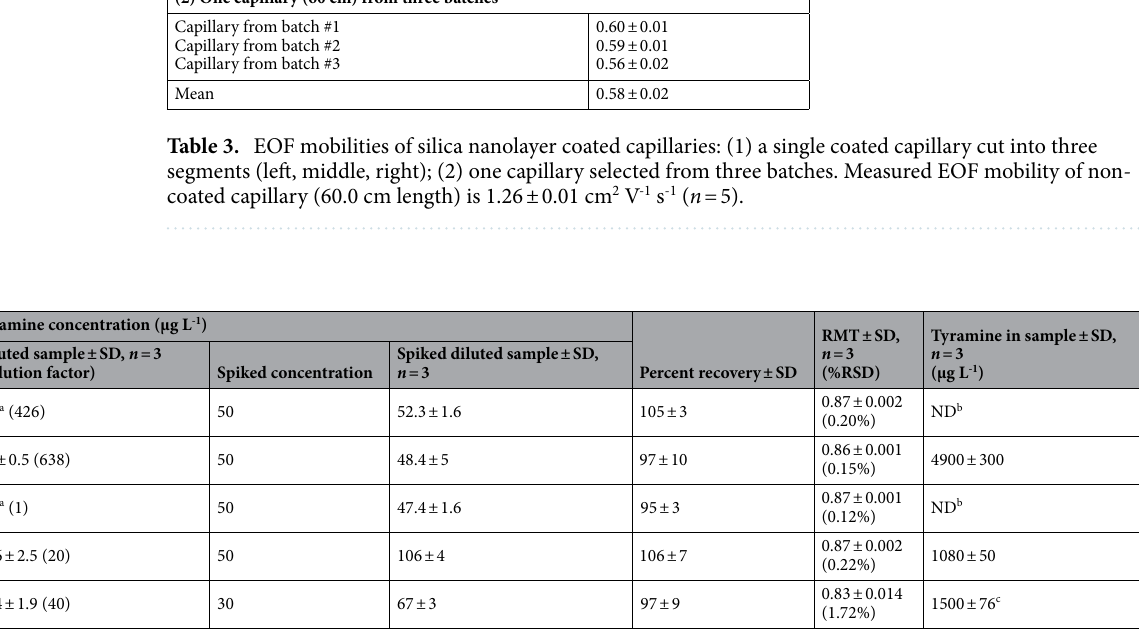
Silica nanolayer coated capillary (1) Capillary cut from 3 segments of a 60 cm capillary Left segment (10.0 cm) Middle segment (10.0 cm)